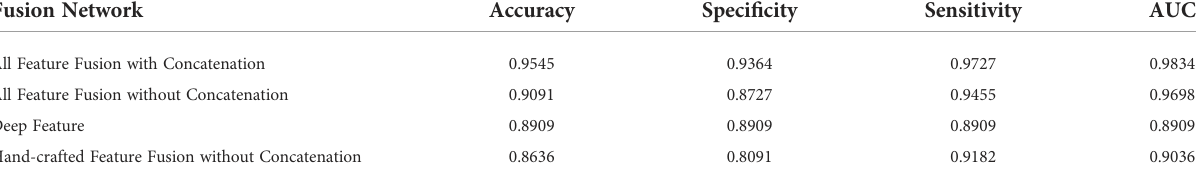
TABLE 4 Classi fi cation performance with different features and feature fusion with/without